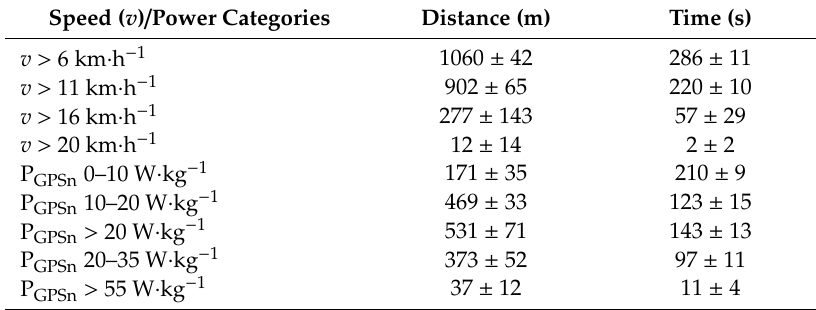
Table 5. Time (s) and Distance (m) were obtained during soccer-specific circuit performance in each speed and power categories.